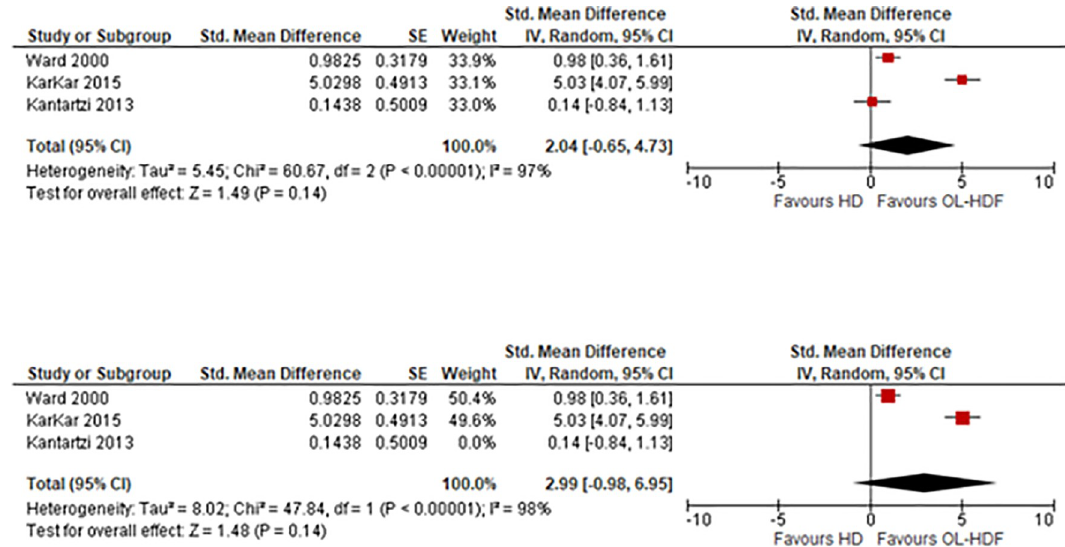
Fig 7. Fig 7–1. Meta-analysis of Emotion, Fig 7–2. Sensitivity analysis of Emotion.